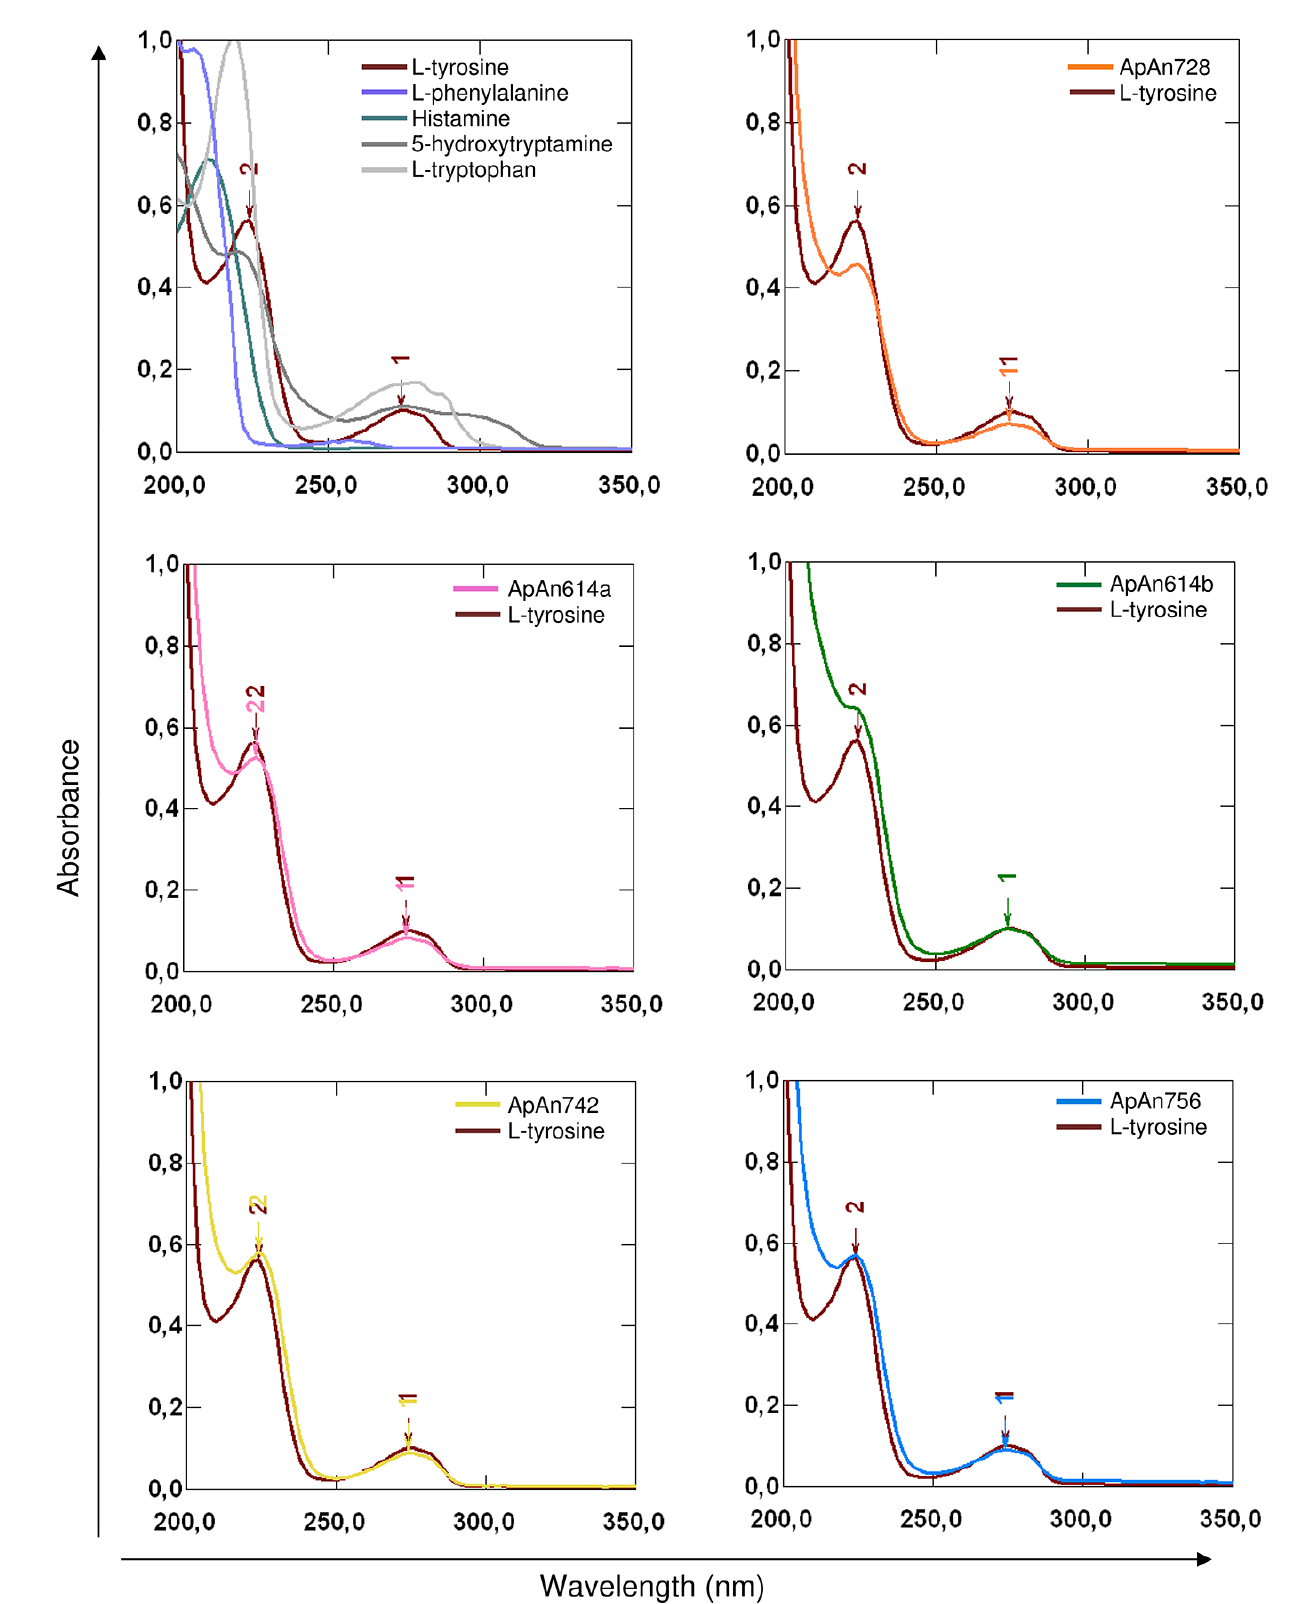
Figure 5. UV absorption spectrum from ApAn728, ApAn614a, ApAn614b, ApAn742 and ApAn756 compared to different compounds. The maximum values of absorption at (2) 224 nm and (1) 274 nm of the samples were coincident with the values shown by L-tyrosine. The spectra were acquired between 200 and 400 nm at room